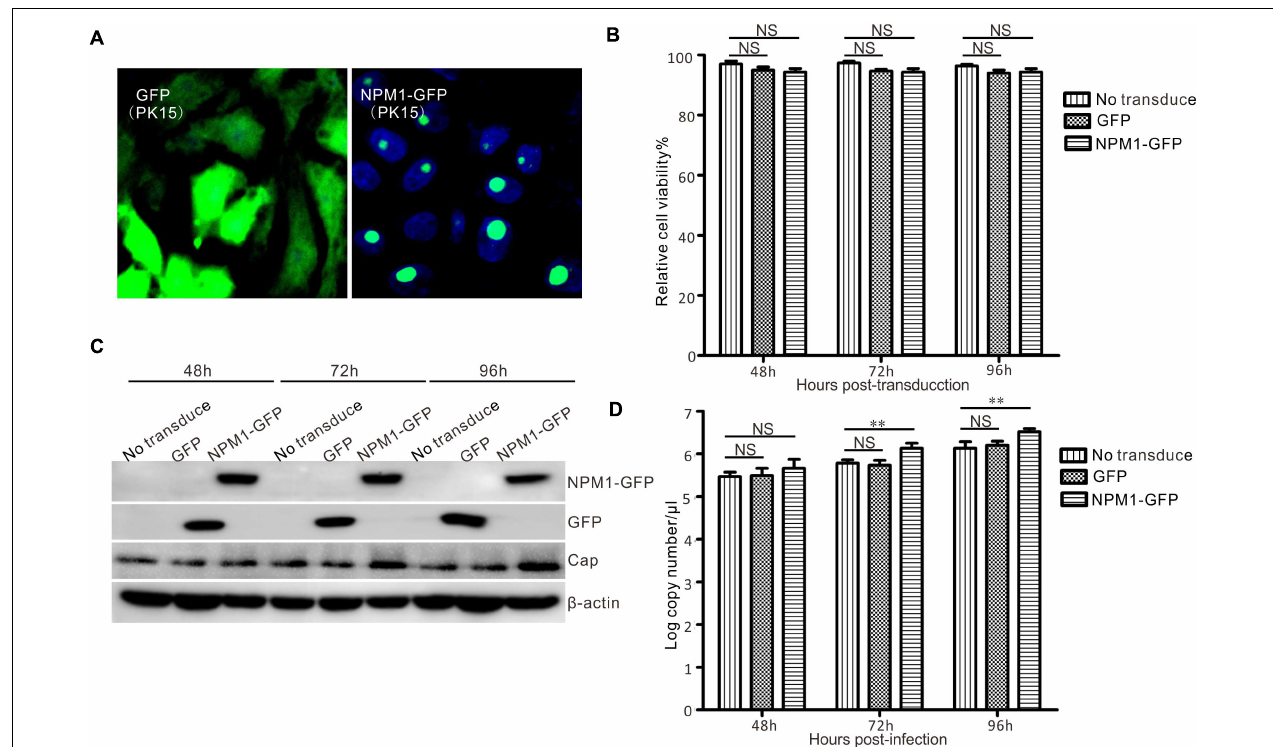
FIGURE 6 | Enhancement of PCV3 replication by NPM1 overexpression in lentivirus-transduced PK15 cells. (A) Lentiviruses were packed in HEK293FT cells, and the lentiviruses of NPM1-GFP and GFP transduced into PK15 cells were examined by microscopy. (B) The viability of lentivirus-transduced PK15 cells was analyzed by CCK-8 assay at 48, 72, and 96 h post-transduction. (C) Lentivirus-transduced PK15 cells and no-transduced PK15 cells were infected with PCV3. The infected cells were harvested at 48, 72, and 96 h post-infection. Western blotting was used to examine the expression levels of Cap, NPM1-GFP, GFP, and β -actin. (D) The copy numbers of viral DNA were determined by qPCR. Data represent the mean ± standard deviation (SD) of three independent experiments (** P < 0.01; NS, not